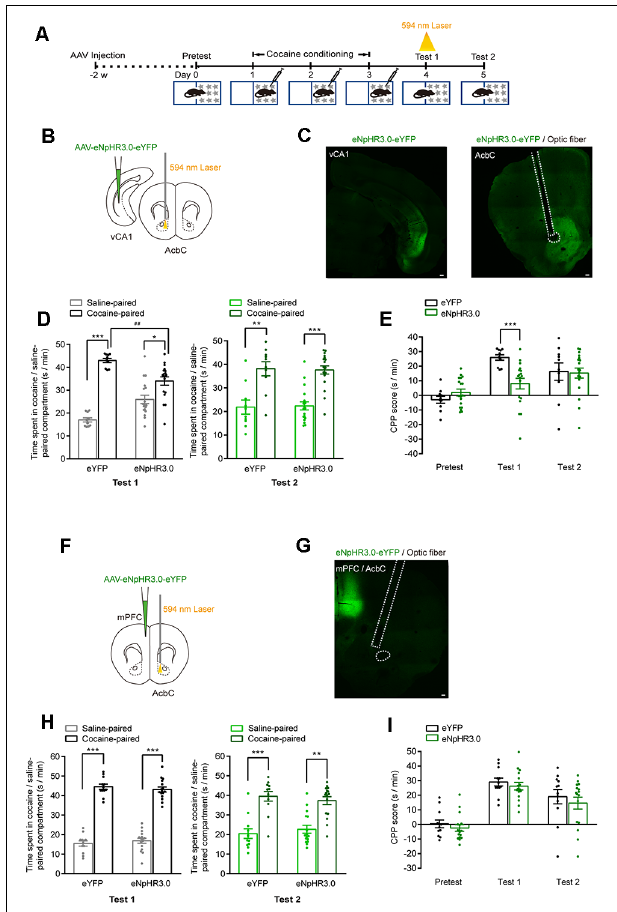
FIGURE 6 | Optogenetic inhibition of vCA1–AcbC projection suppressed the retrieval of cocaine-CPP memory. (A) Behavioral schedule. AAV-EF1 α -eNpHR3.0-eYFP was injected in the vCA1 or mPFC, and optical fiber was implanted in the AcbC 2 weeks before CPP training. A 594-nm yellow laser (5 mW, 5 min) was delivered during test 1. (B,F) Viral injection and optical fiber implantation. (C,G) Representative images of eNpHR3.0-eYFP fluorescence and location of optical fiber in the AcbC. Scale bar: 100 µ m. (D,H) Bar graphs representing the time spent in the cocaine-paired and the saline-paired compartments of eYFP and eNpHR3.0 groups in the test 1 and test 2 sessions. * P < 0.05, ** P < 0.01, *** P < 0.001 vs. saline-paired compartment, ## P < 0.01 vs. eYFP group. (E,I) Bar graphs showing the CPP scores of eYFP and eNpHR3.0 groups. *** P < 0.001 vs. eYFP group (vCA1–AcbC: eYFP n = 10, eNpHR3.0 n = 18; mPFC–AcbC: eYFP n = 12, eNpHR3.0 n =